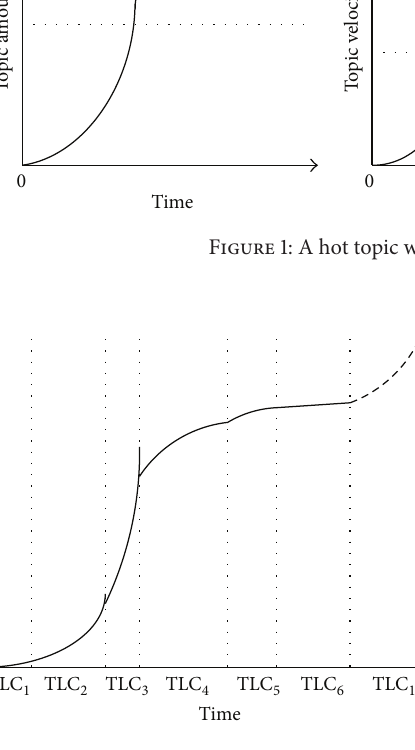
Figure 2: A topic life cycle with different